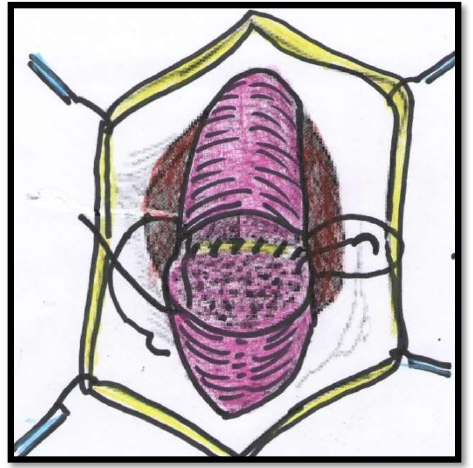
Figure 1. The urethral epithelium sutured with a continuous running suture and the spongiosum sutured in the same fashion separately.